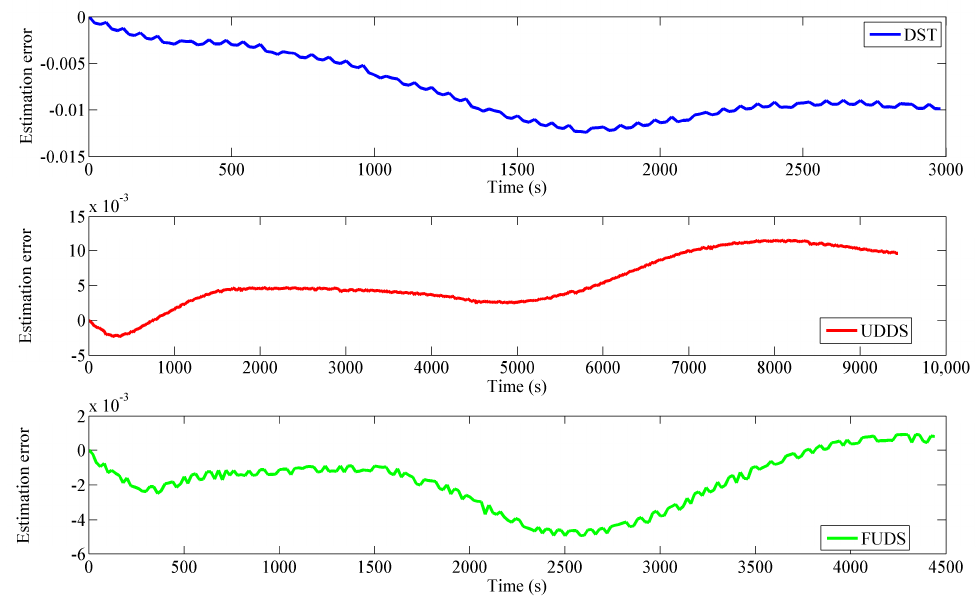
Figure 17. Discharge current of Dynamic Stress Test (DST), Urban Dynamometer Driving Schedule (UDDS), and Federal Urban Driving Schedule (FUDS) tests.